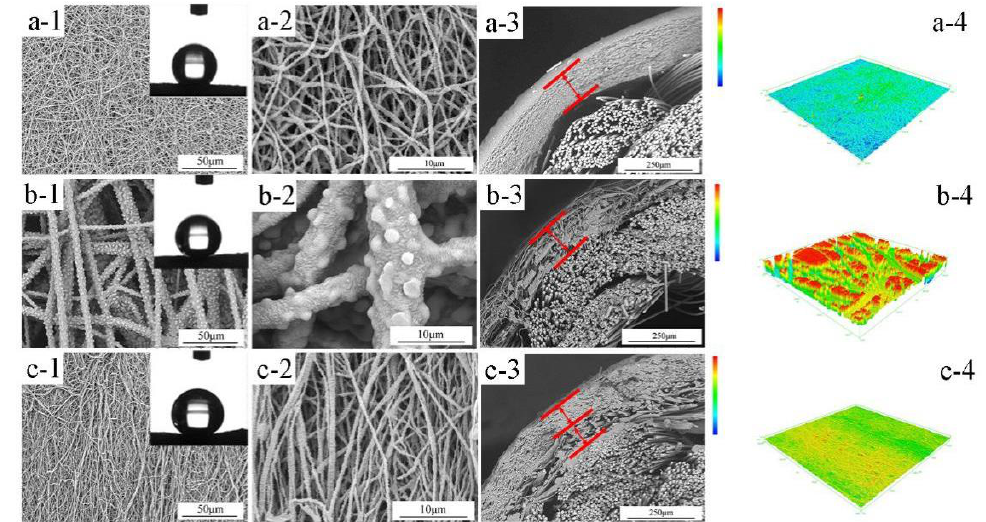
Figure 3. SEM images and the corresponding 3D confocal laser scanning microscope (CLSM) images of the sintered ultrafine fibrous PTFE hollow fiber membranes: ( a ) the sintered M-1 membrane; ( b ) the sintered M-2 membrane; ( c ) the sintered M-3 membrane; (1) surface × 800; insets were the photos of WCA; (2) surface × 5000; (3) the cross-section; (4) 3D CLSM images.